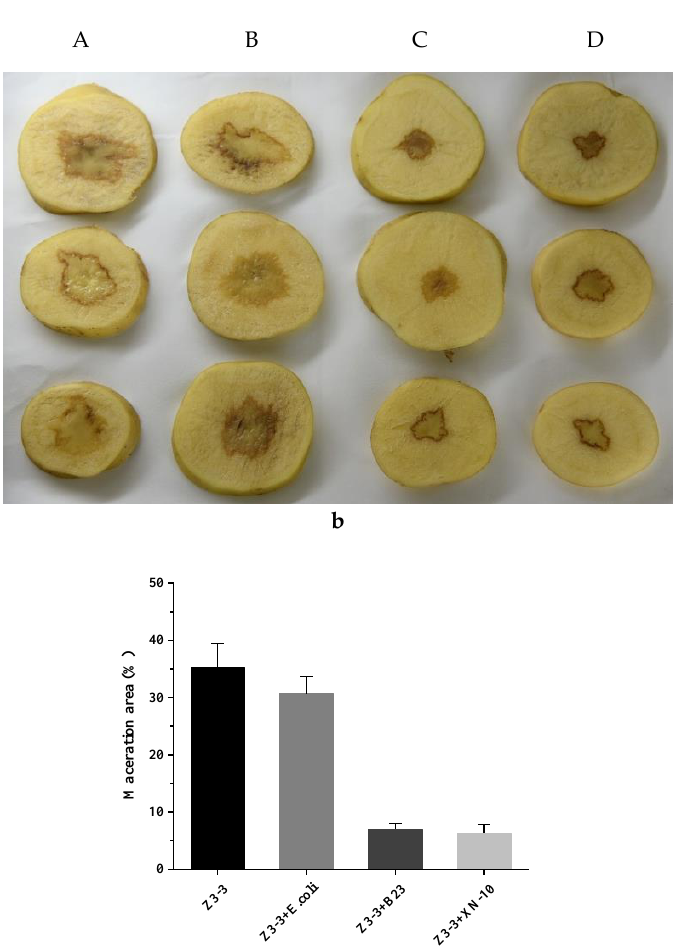
Figure 6. Biocontrol test of strain XN-10 against Pectobacterium carotovorum subsp. carotovorum ( Pcc ) on potato slices under laboratory conditions. ( a ) Attenuated maceration of Pcc strain Z3-3 by strain XN-10 on potatoes. A: inoculation of Z3-3 alone; B: co-inoculation of Z3-3 and Escherichia coli DH5 α ; C: co-inoculation of Z3-3 and Bacillus thuringiensis subsp. israelensis B23; and D: co-inoculation of Z3-3 and strain XN-10. ( b ) Tissue maceration rates in each